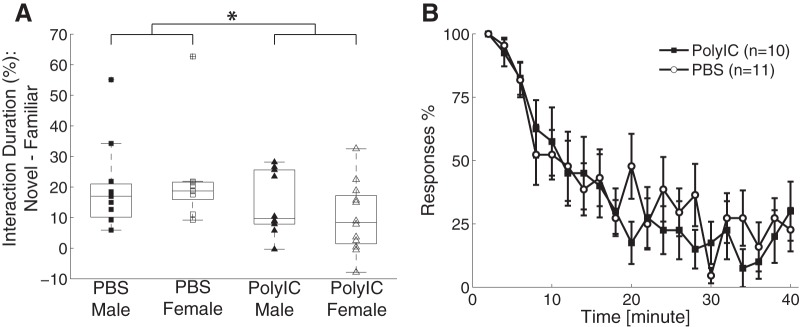
Effects of MIA on novel object recognition and adaptation to repeated auditory stimulus. A, Novel object recognition defined as the percentage of the time interacting with a novel object minus the time interacting with a familiar object. Configuration the same as used in Figure 1. B, Adaptation to repeated auditory stimulus. For clarity, the data are binned in 2-min windows. Error bars represent SEM. *p < 0.05.